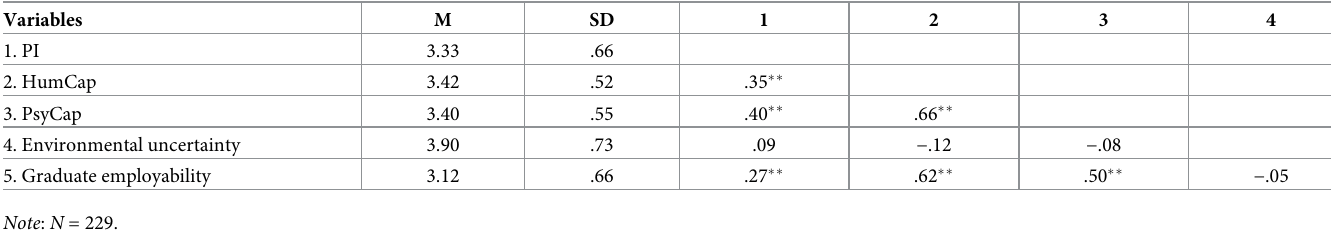
Table 3. Descriptive statistics and inter-correlations among the hypothesized